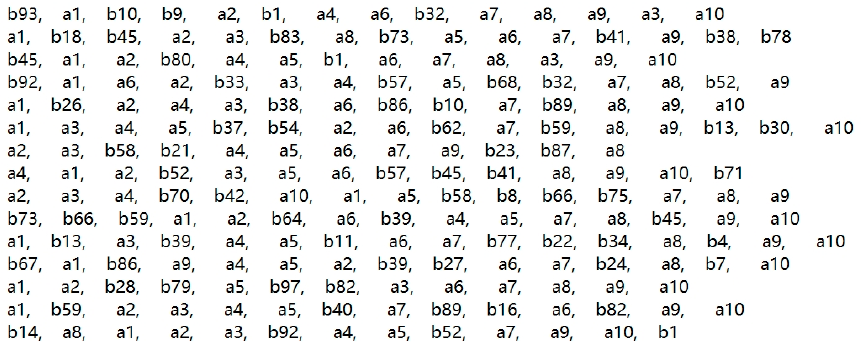
Figure 8. A fragment of the first type of data. Each row denotes a pattern session.